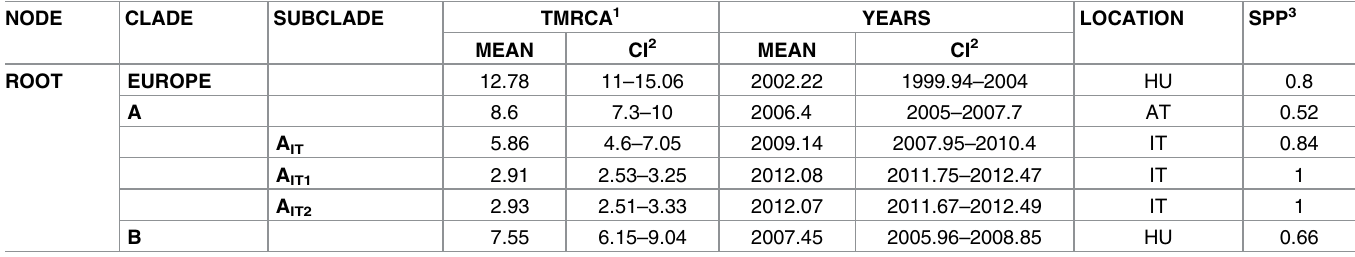
Table 2. Estimated times of the most recent common ancestors (tMRCAs)of the main clades and credibility intervals (95%HPD), with calendar years, most probable locations, and state posterior probabilities (spp) of the 77 complete genomes of West Nile virus. NODE